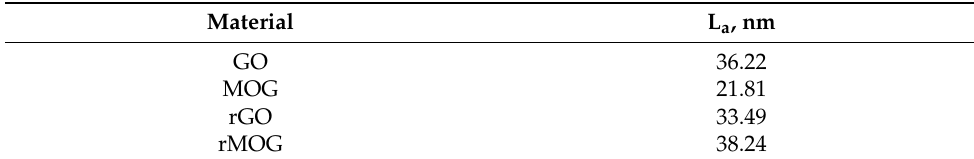
Figure 2. Raman spectra of the ( a ) GO and MOG films; ( b ) rGO and rMOG powders. Table 1. Lateral size of domains with sp 2 hybridization.